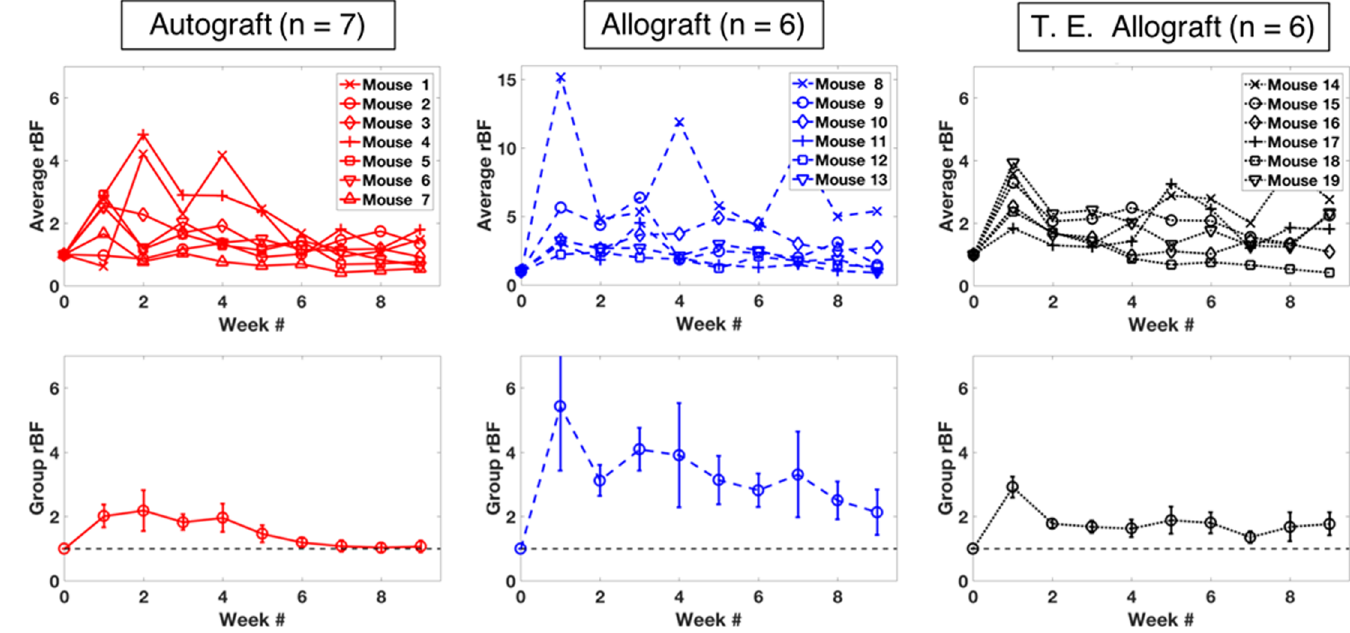
Fig 5. Average blood flow in the graft region ( rBF g ) during the 9 weeks of healing. The first row shows the individual temporal changes in the different graft groups, and the second row shows the corresponding group average with the standard error of the mean. In order to show the full range of temporal changes for the individual mice in the allograft group, a different rBF range is chosen (top middle plot), whereas other plots are fixed with the same rBF range.